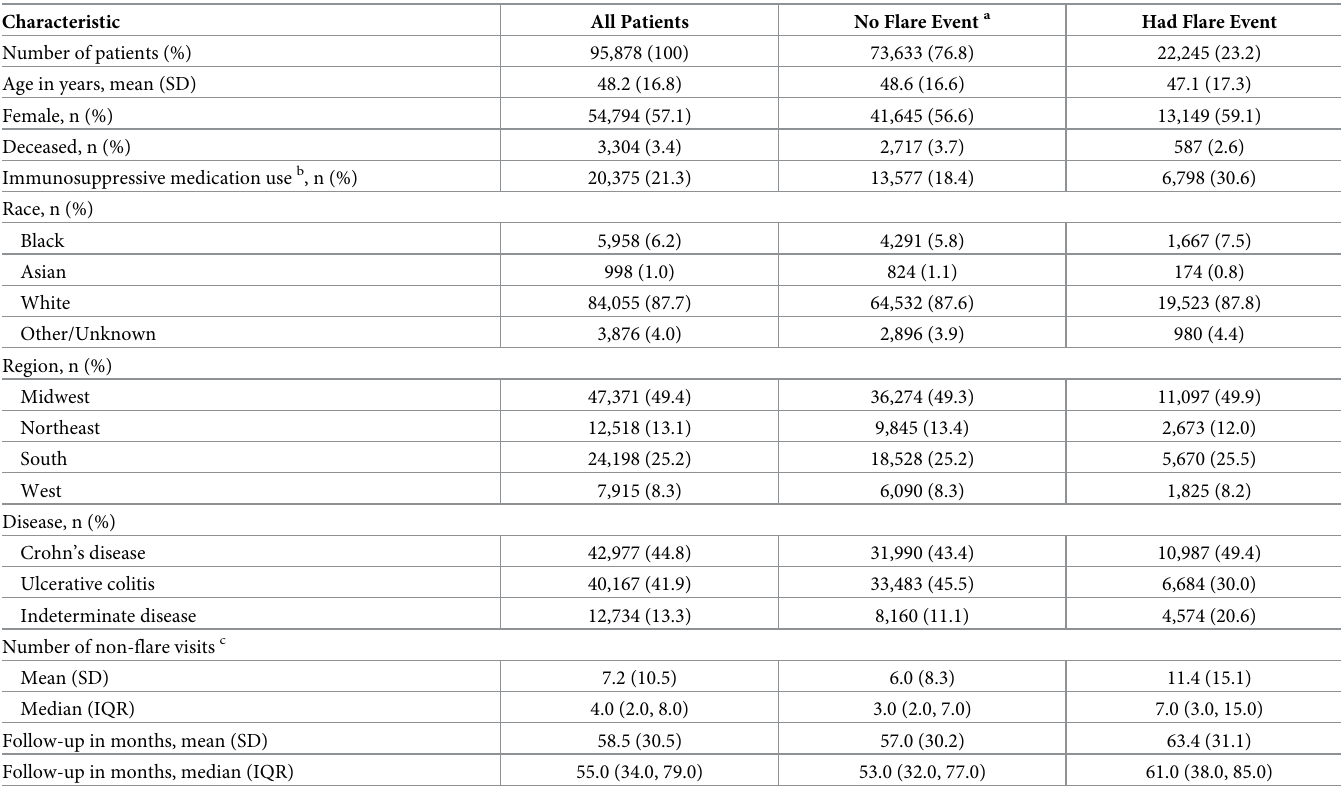
Table 1. Patient